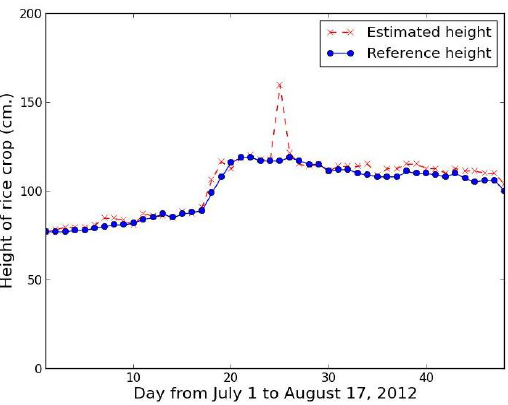
Figure 24. Rice crop height series from 1 July to 17 August 2012 using proposed method with excess green feature.